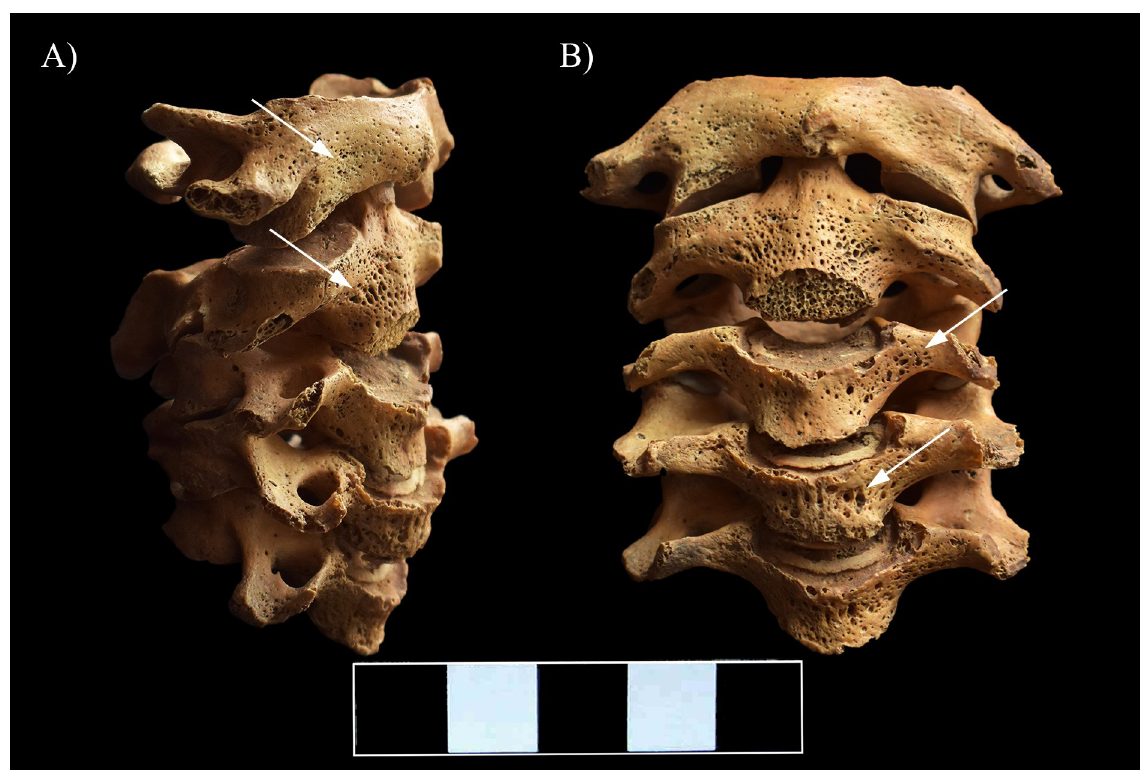
Fig 5. Pitting and slight cortical remodeling on the C1–5 vertebrae (white arrows). A) Lateral view (right side) and B) Anterior view.